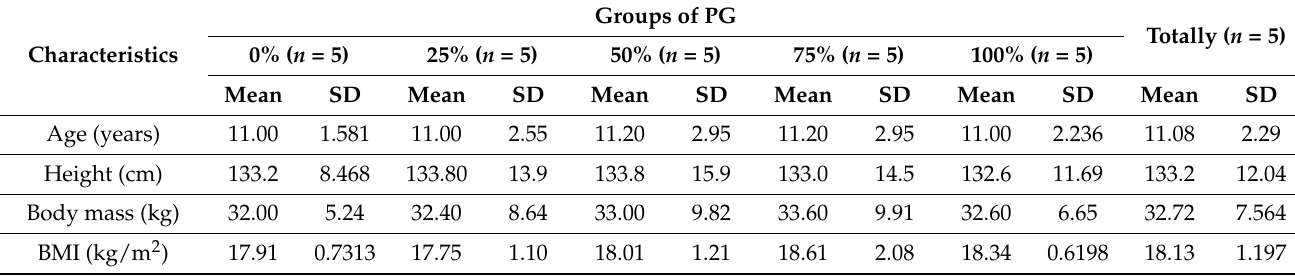
Table 1. General characteristics of the participants by physical guidance.